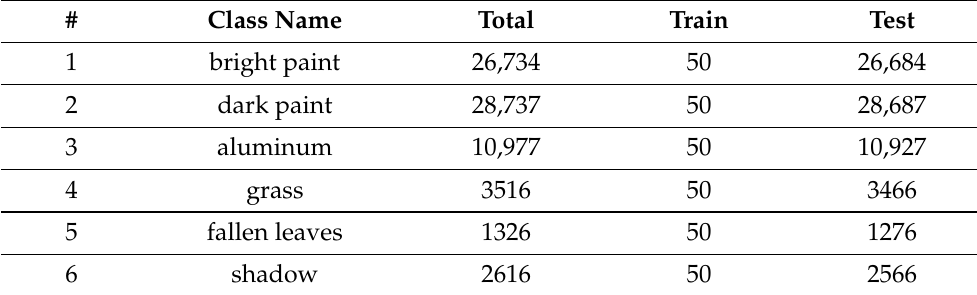
Table 5. Number of train and test sample in the YU Paint